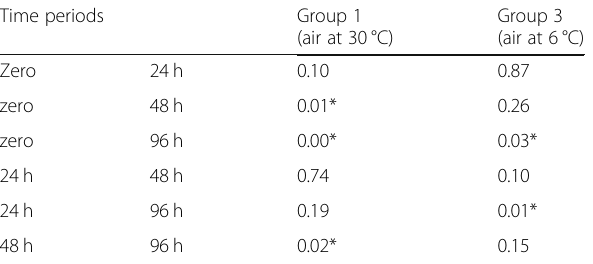
Table 4 Pairwise comparisons for each time point of the skin GAPDH level in groups 1 and 3